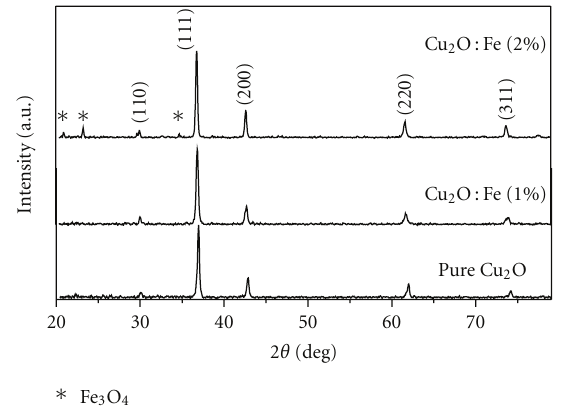
Figure 15: XRD patterns of pure Cu 2 O, 1% “Fe”-doped single phase Cu 2 O, and 2% “Fe”-doped Cu 2 O with impurity peaks of Fe 3 O 4 .